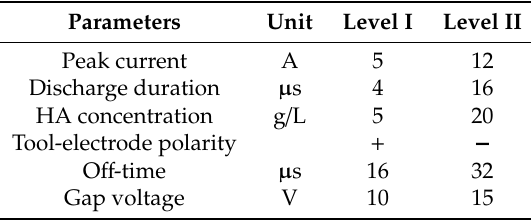
Table 1. Input parameters and levels for screening experiment.